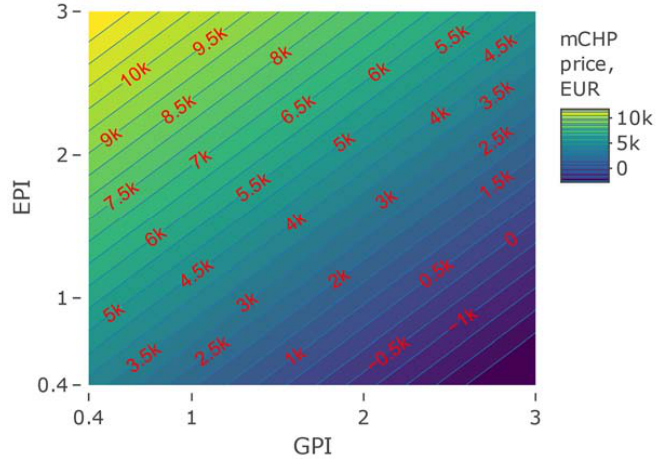
Figure 9. mCHP price, as an EPI and GPI function at which an investment in mCHP would be economically profitable for the analyzed building.